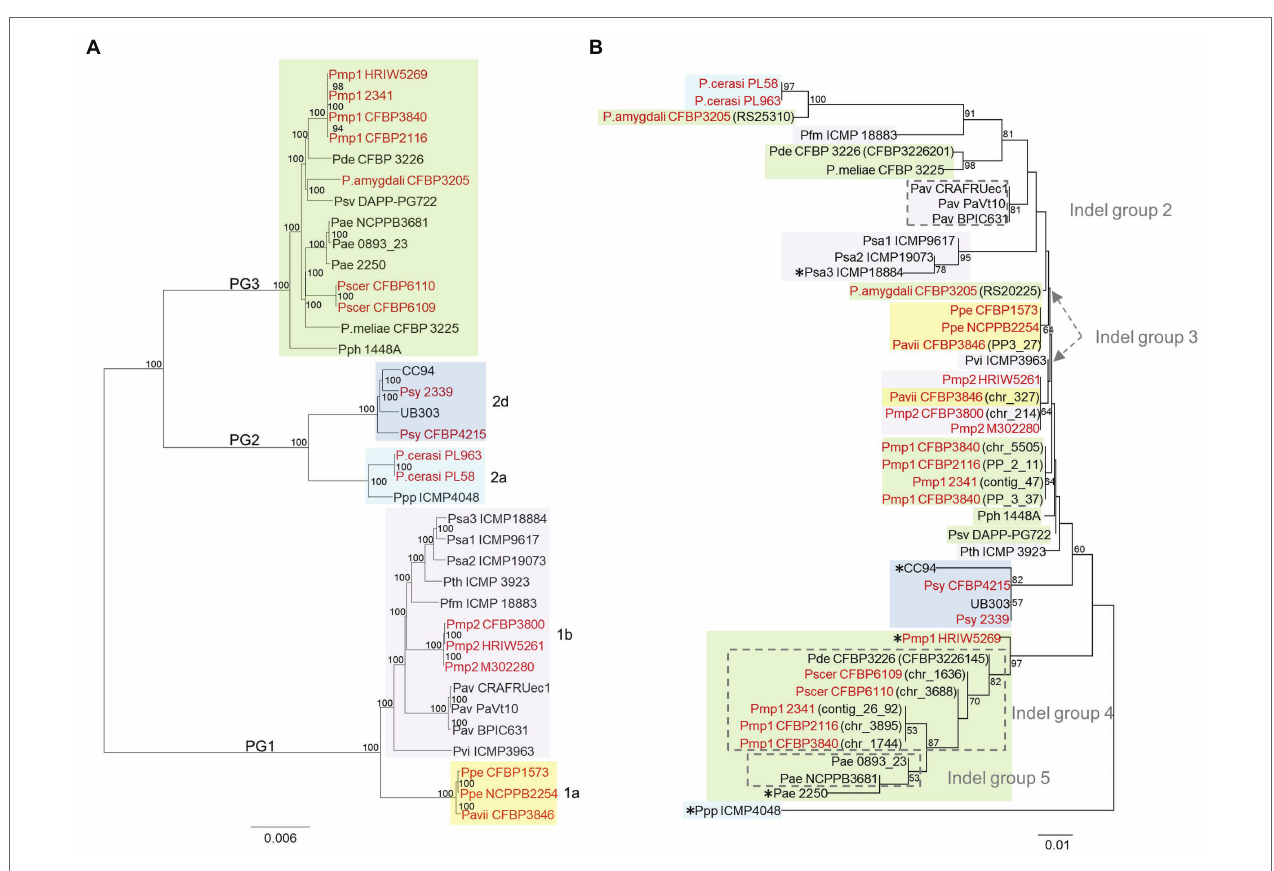
FIGURE 5 | Comparison of the neighbor-joining phylogeny based on the core genome (A) and on HopAY (B) . (A) The core genome of the 36 strains possessing an hopAY ortholog based on the BLASTN search was determined using EDGAR 2.2 (Blom et al., 2016) out of a core genome of 2,511 CDS giving a total alignment of 872,675 amino acids per genome. The strain names used refer to the code field from Table 1 . Phylogroups and clades are indicated on the left and on the right, respectively. (B) The phylogeny of the 43 retrieved HopAY sequences was computed using the Jones–Taylor–Thornton model matrix-based with a gamma distribution (shape parameter = 2.25). Percent bootstrap (bt) support values calculated for 1,000 reiterations are indicated near nodes. Only bt values over 51 are displayed. All ambiguous positions were removed for each sequence pair giving a total of 323 positions in the final data set. Evolutionary analyses were conducted in MEGA 6.0. Indel groups (gray dashed lines boxes) refer to Figure 4 . Asterisks (*) indicate strains with unique indel profiles. If nothing stated, sequences belong to indel group 1. For strains possessing multiple copies of HopAY, the locus tag is indicated in brackets. Strains isolated from Prunus spp. are highlighted in red. PG and clades are indicated with the same color code as used on the left in panel (A)